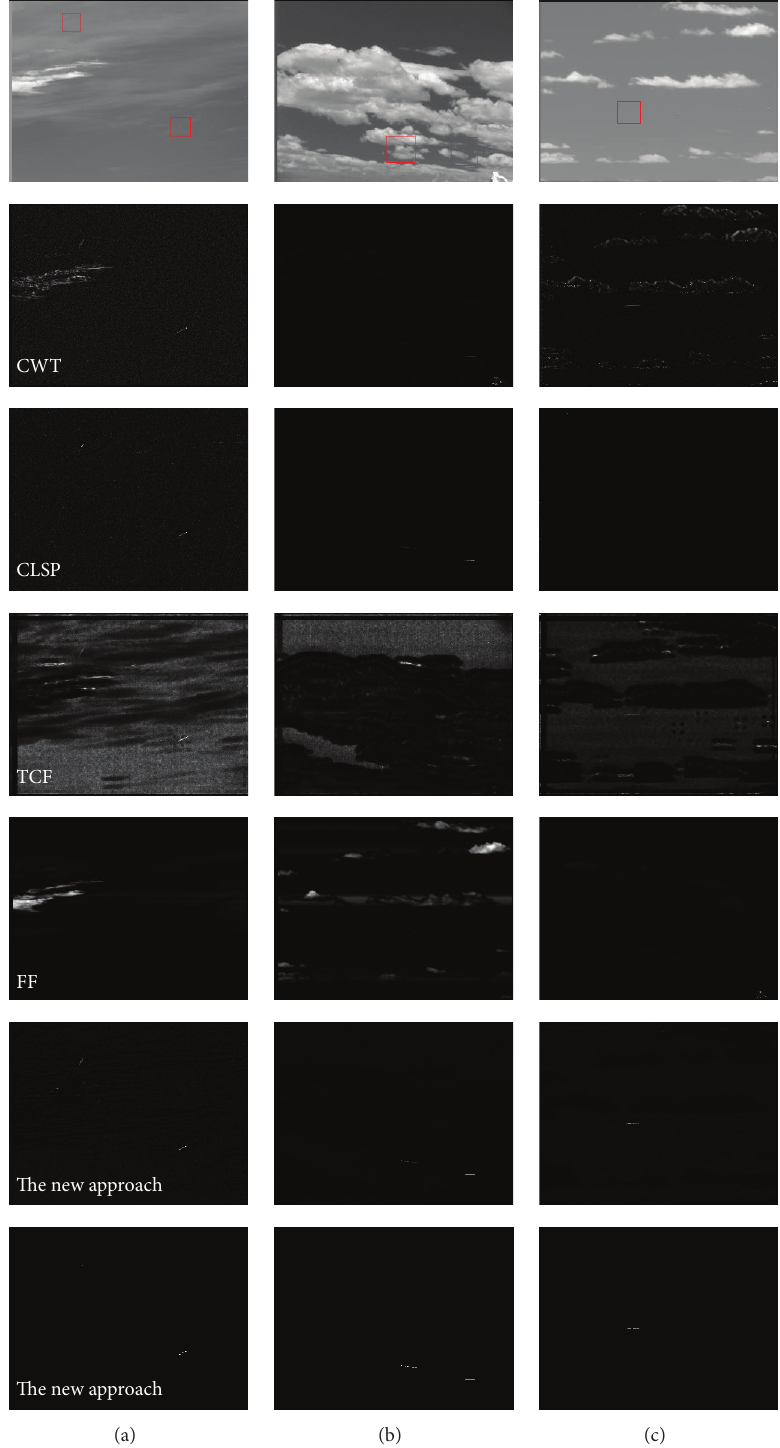
Figure 10: Detection results. (a) Detection result of “npa” scene. (b) Detection result of “j2a” scene. (c) Detection result of “na23a”